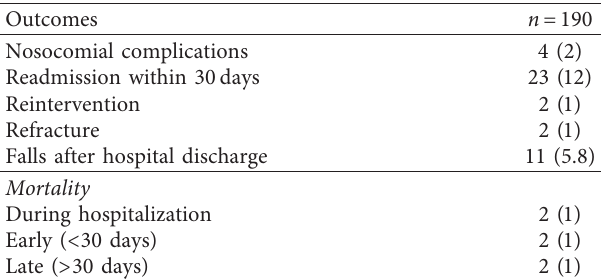
Table 4: Complications and morbidity outcomes during the first year of the program.